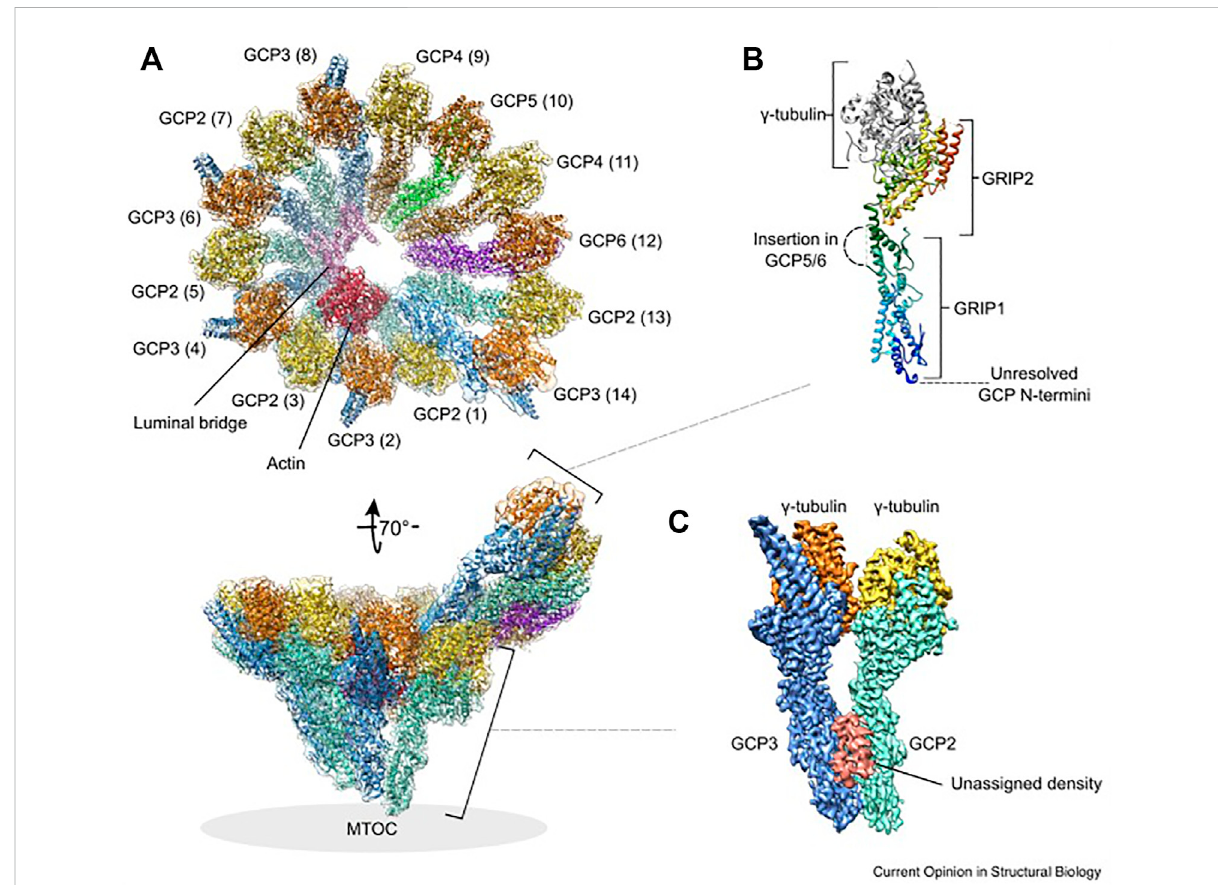
FIGURE 2 Structure and molecular architecture of human γ -TuRC. (A) General architecture of the left-handed γ -TuRC spiral as determined by cryo-EM single-particle analysis, resolution 3.8 Å. γ -Tubulins (yellow, orange), GCP2 (aquamarine), GCP3 (blue), GCP4 (brown), GCP5 (green), GCP6 (purple), actin (red) andtheluminalbridge (pink) are shown. The spokes (GCP- γ -tubulinheterodimers)are numbered (1 – 14 inbrackets).Inthetilted view,the approximate location of the MTOC is indicated. The orientation of subcomplexes shown in panel (B) and (C) is indicated. (B) General architecture of a GCP- γ -tubulin spoke. The GCP N-terminal GRIP1 and C-terminal GRIP2 domains are annotated. Unresolved GCP segments are indicated by dashed lines. GCP is shown in rainbow colors from N-terminus (blue) to the C-terminus (red). (C) Location of the unassigned density segment (red) present on each GCP(2 – 3) subcomplex of the human γ -TuRC. This fi gure was prepared using PDB 6V6S and EMD-21074. Reprinted by permission from Current Opinion in Structural Biology (Zupa et al.,